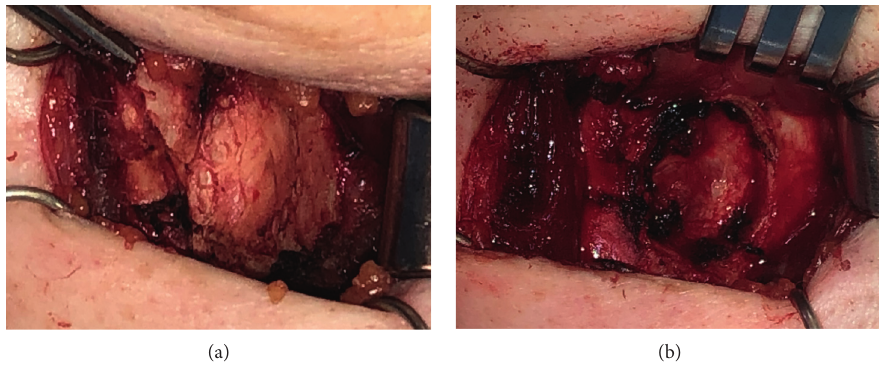
Figure 4: (a) Ovoid, vertically oriented mass within the lamina of the left thyroid cartilage. (b) Defect in thyroid cartilage after removal of mass. The inner perichondrium was left intact.